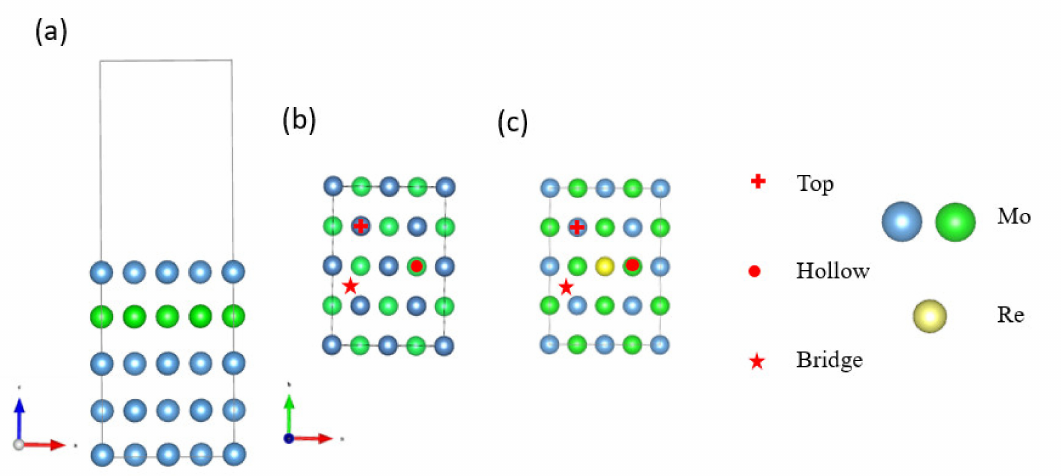
Figure 1. Structure of Mo/Mo-Re (110) surfaces and adsorption sites: ( a ) side view of Mo/Mo-Re (110) slab model; ( b ) Top view of Mo (110) surface and ( c ) top view of Mo-Re surface. Blue and green spheres represent Mo atoms, and yellow spheres represent Re atoms.